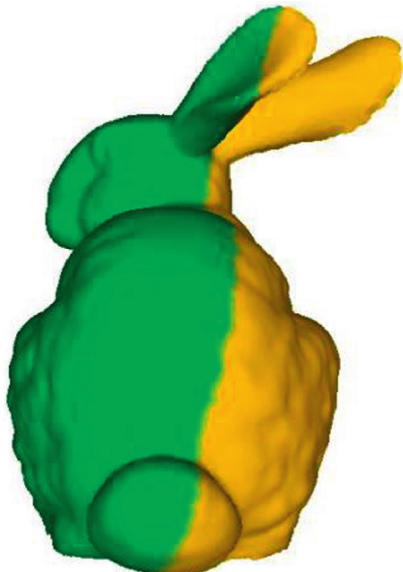
Figure 1: Symmetry plane obtained by one PCA process, taking bunny model for